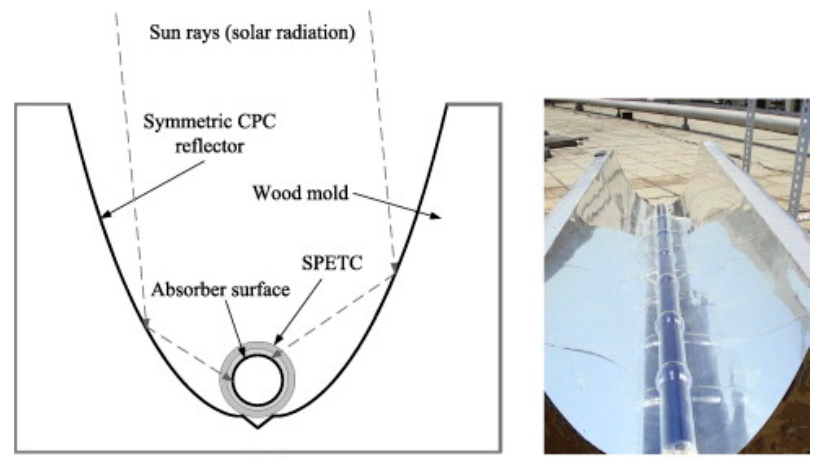
Figure 13. Schematic diagram of the CPC with single-pass evacuated tubular collector (left: Cross-section; right: Experimental setup) [33].